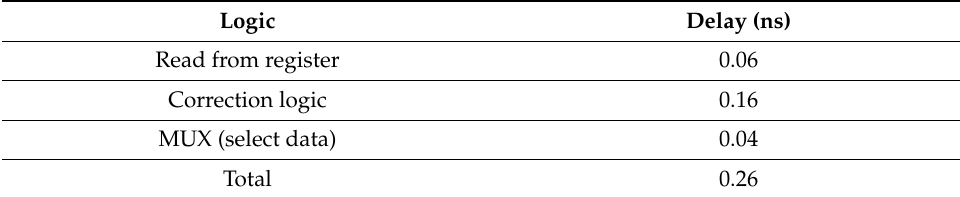
Table 9. Second-stage timing of the SEC–DED–DAEC decoder.